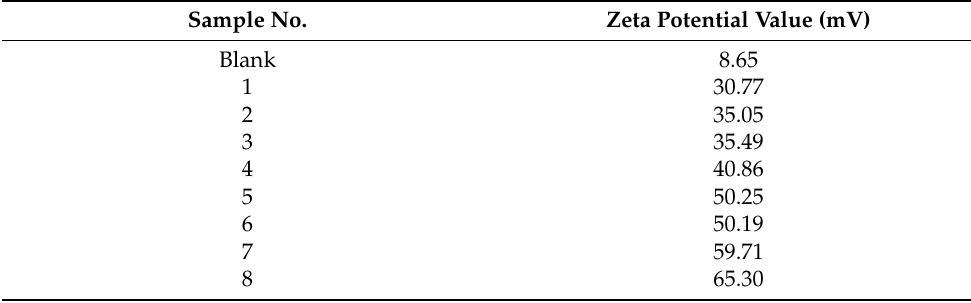
Table 5. Zeta potential of graphite before and after modification with CTAC. Sample